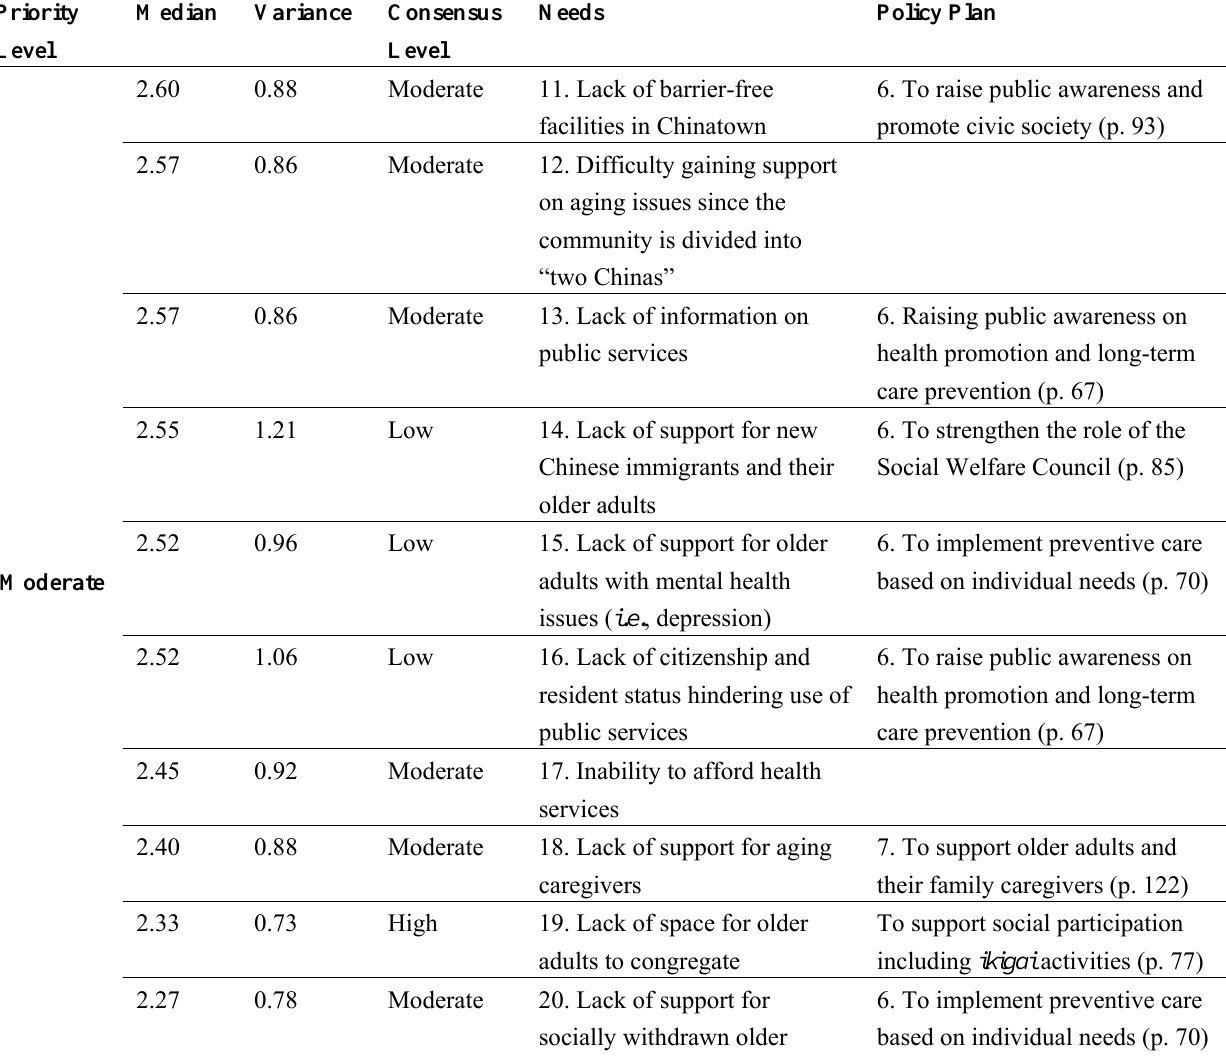
Table 3. Moderate priorities, levels of consensus, and corresponding city’s policy plan for 30 needs identified from focus group interviews with ethnic Chinese